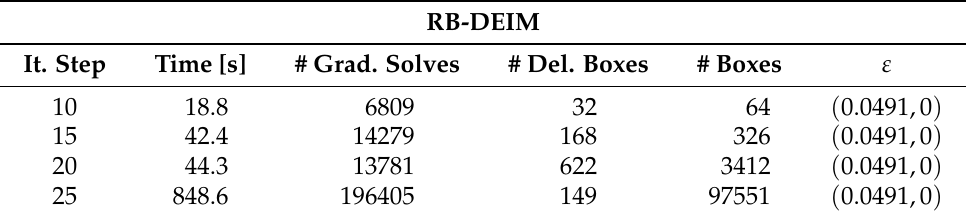
Table 2. Subdivision algorithm with the steepest descent method.